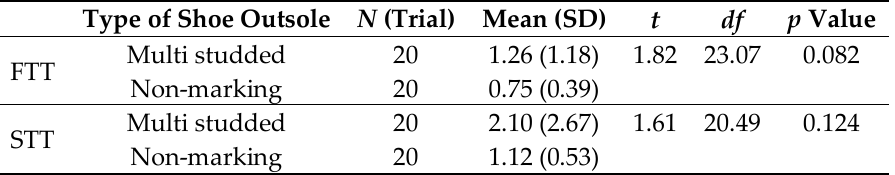
Table 2. Comparison of maximal coefficients of traction (COT max ) between multi studded outsole design and non -marking outsole design during front translational traction (FTT) and side translational traction (STT)